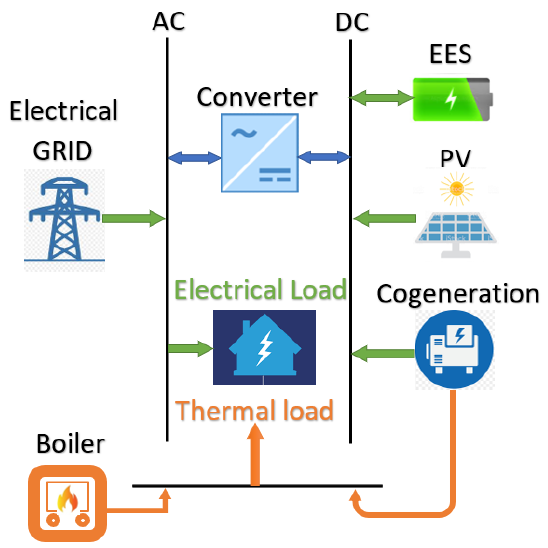
Figure 2. Generic hybrid energy system configuration utilized in this study.